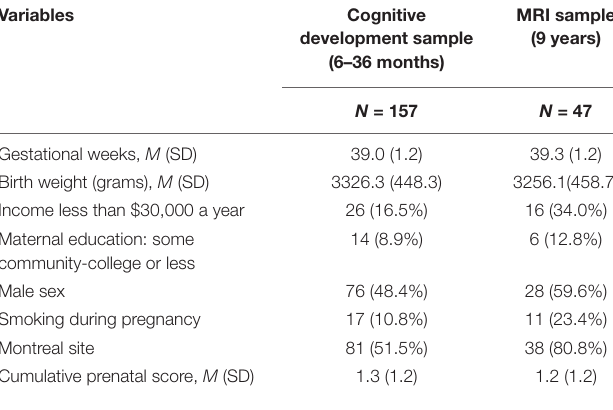
TABLE 1 | Maternal Adversity, Vulnerability and Neurodevelopment (MAVAN) sample